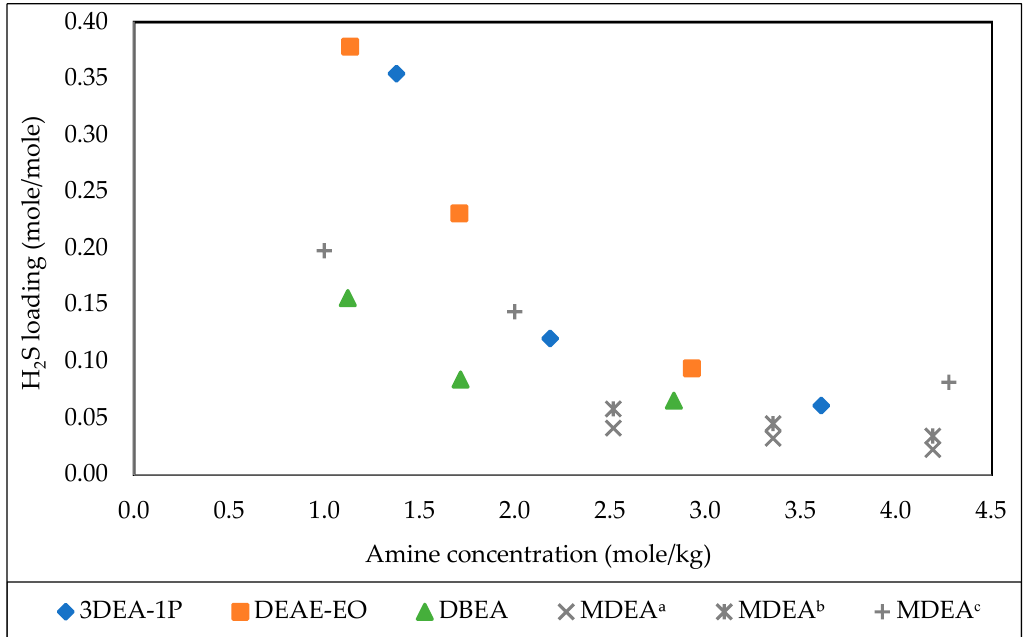
Figure 9. Effect of amine concentration on H 2 S loading; T = 5 ◦ C ± 0.1 ◦ C; pH 2 S = 1 kPa for all amines except MDEA; DBAE solutions makes two phases.; MDEA is at T = 40 ◦ C and MDEA a pH 2 S = 0.3 kPa [27]; MDEA b pH 2 S = 0.5 kPa [27], MDEA c pH 2 S = 1 kPa